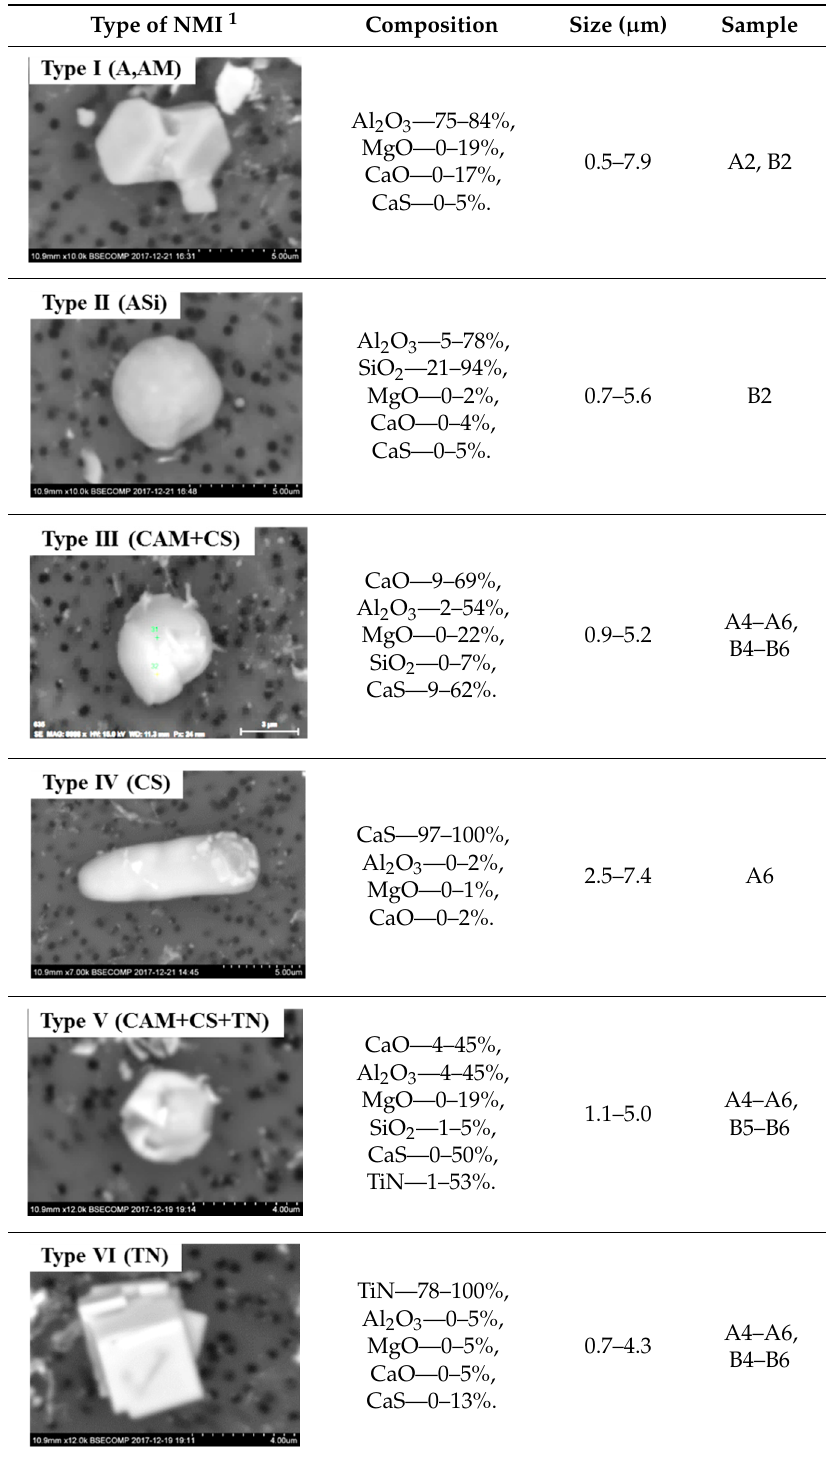
Table 2. Classification of typical non-metallic inclusions observed in di ff erent steel